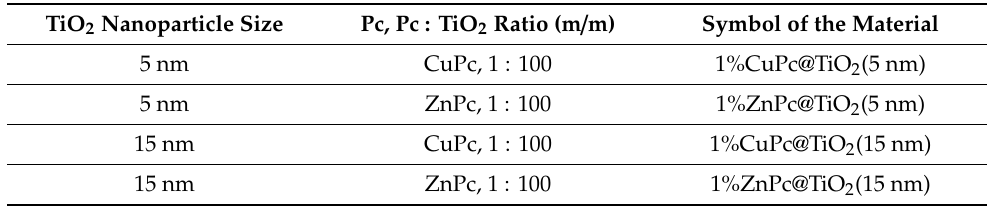
Table 1. Hybrid TiO 2 -Pc materials applied in the